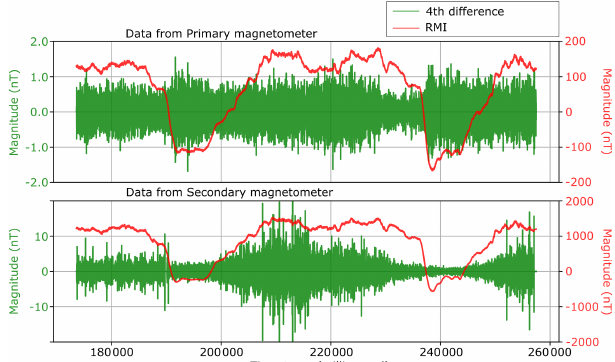
Figure 9. Data excerpt of RMI profiles recorded by the primary and secondary magnetometer and their respective fourth differ- ence while the UAV was flown manually in the multi-rotor mode on 13 January 2020 with d = 20cm and L = 20cm. The IGRF (50560nT) has been